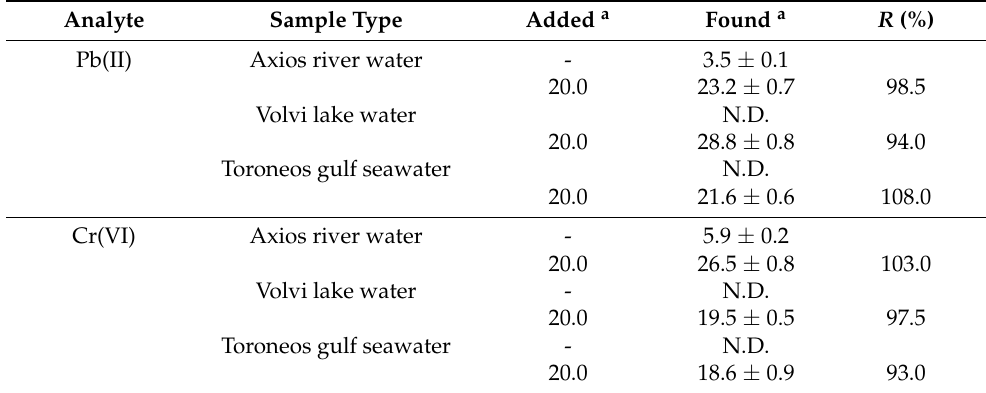
Table 5. Application of the FI-FCSE-FAAS method for lead and chromium(VI) determination in spiked natural water